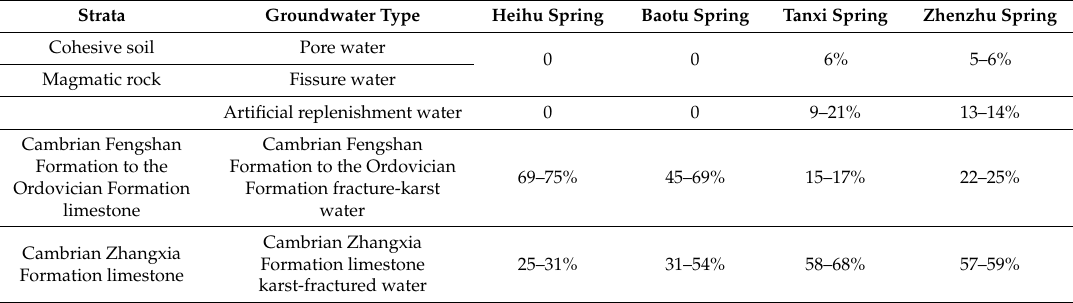
Table 6. Connections of di ff erent types of groundwater to